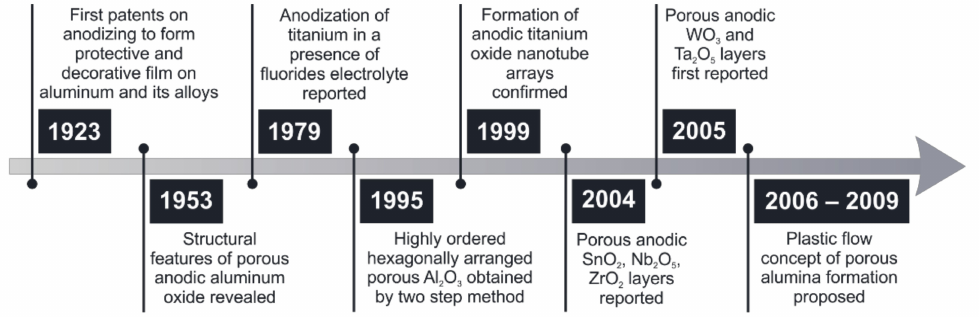
Figure 1. Timeline of the most relevant events in the history of anodizing of metals.